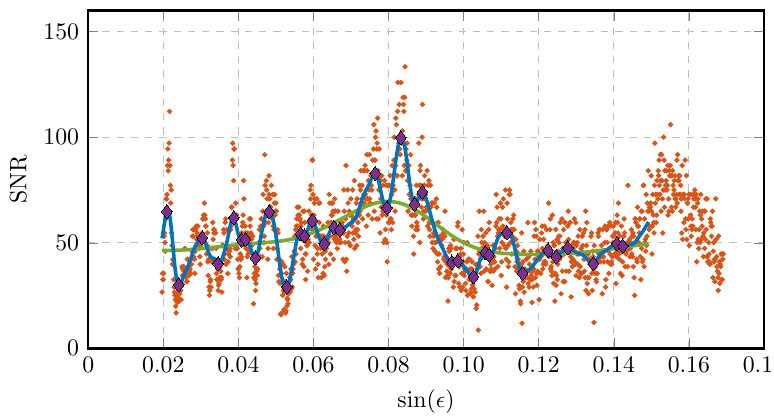
Figure 4. Depiction of kernel regressions and detection of local extrema for scattered data that do not exhibit a pronounced interference pattern. The meaning of the colors is similar to that in Figure